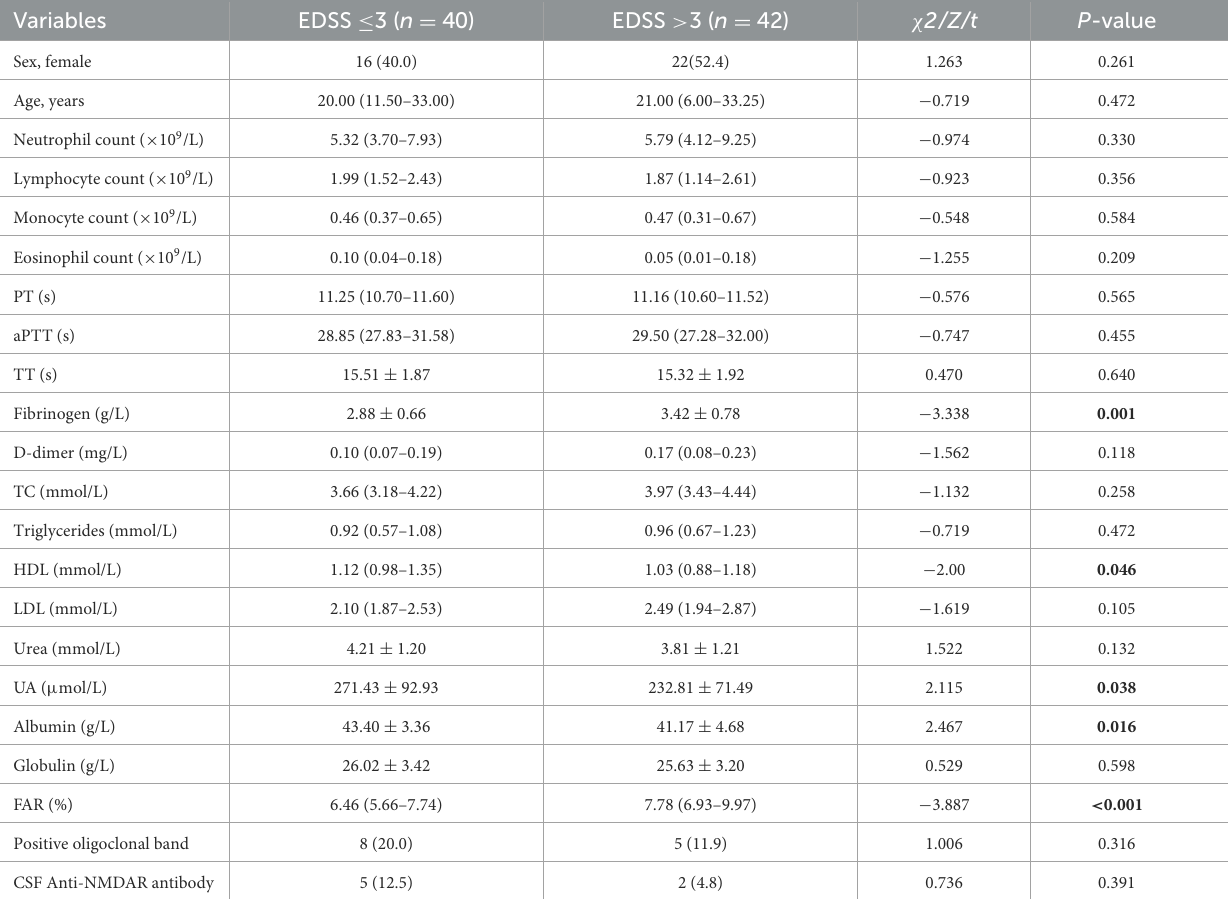
TABLE 5 Laboratory data according to the initial expanded disability status scale (EDSS)